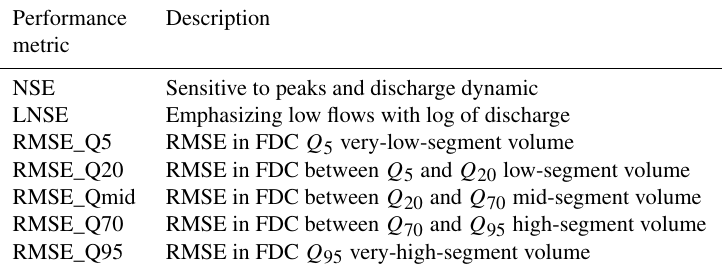
Table 2. Definitions of the performance metrics.